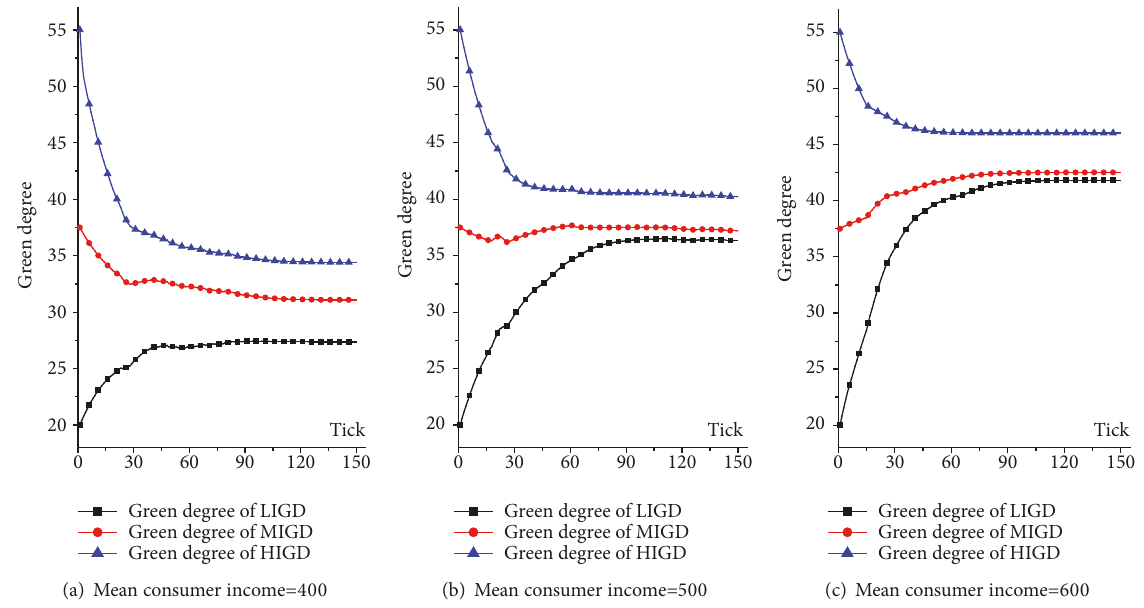
Figure 3: Green degree evolutions of the three manufacturer categories under different